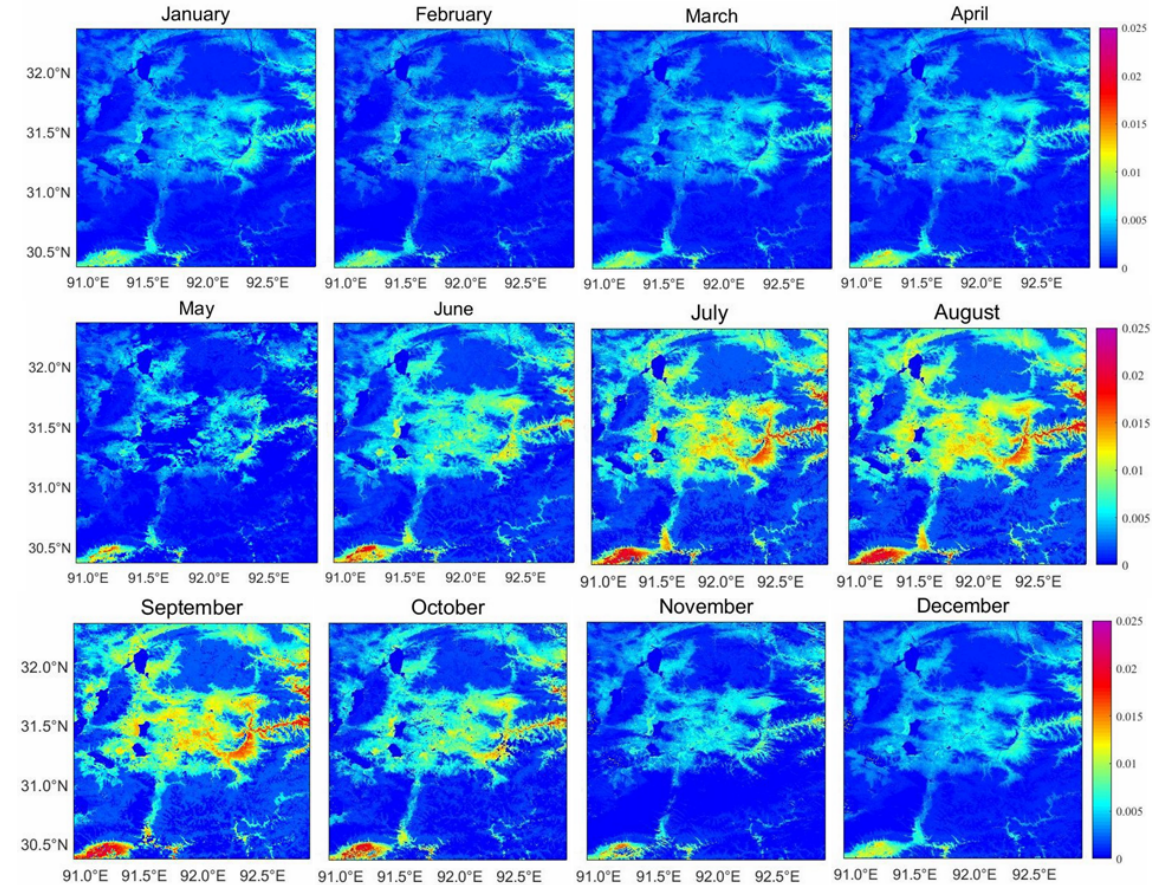
Figure 4. Surface roughness length on the northern Tibetan Plateau in